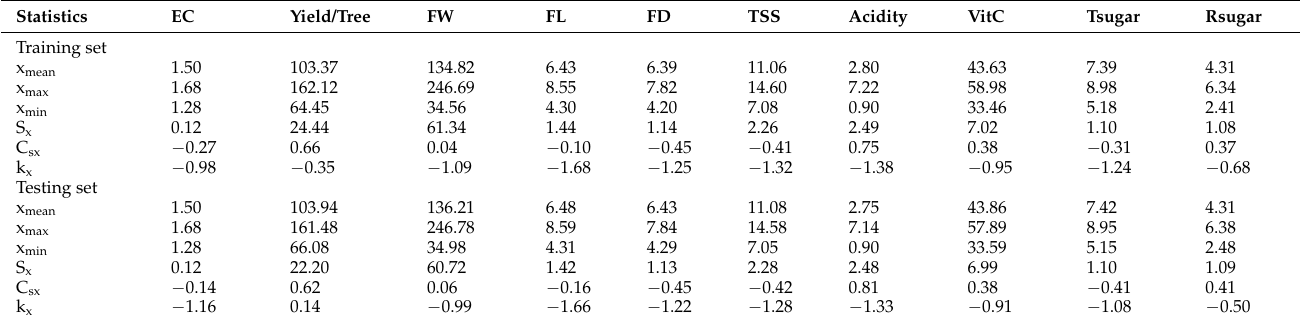
Table 2. Descriptive statistics of the variables used in models development.